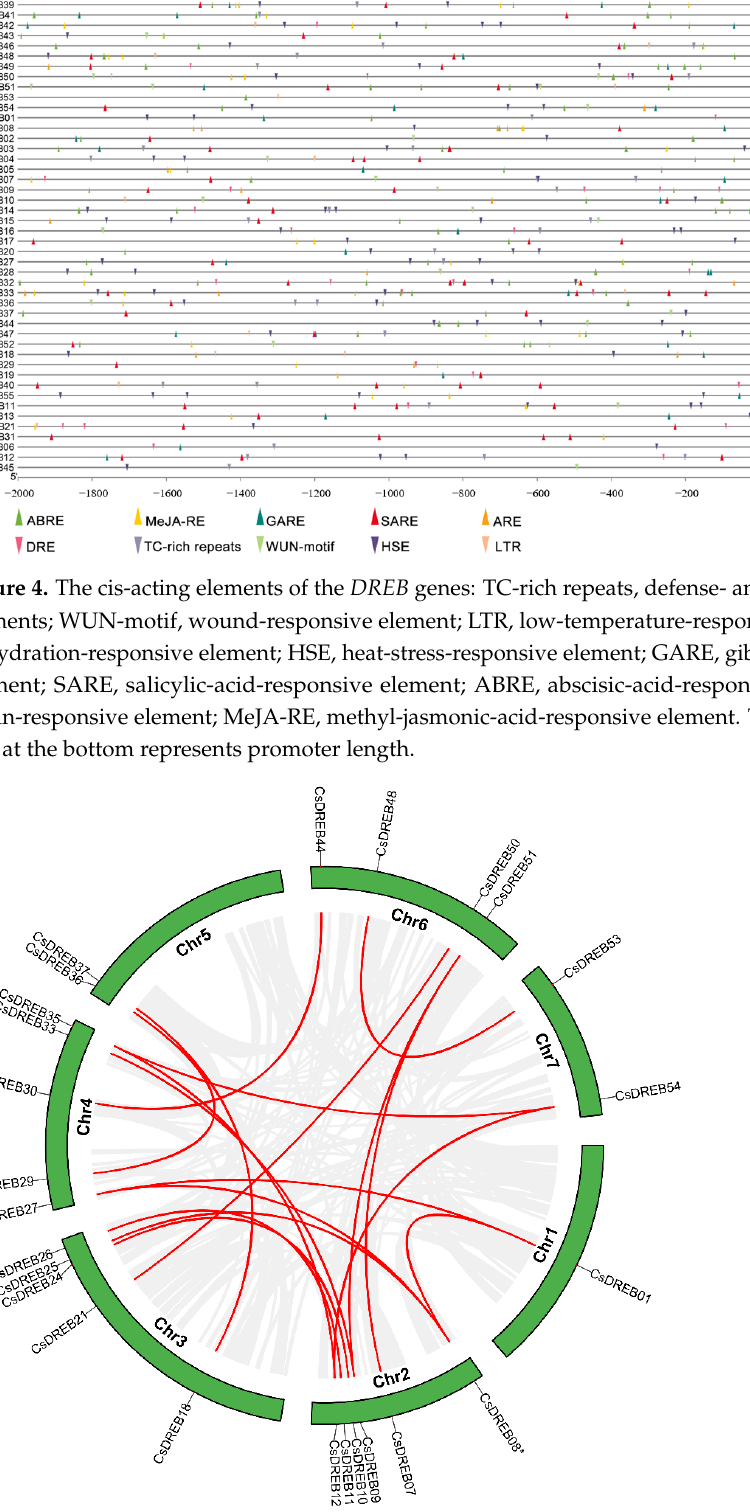
Figure 5. Schematic representations for the inter-chromosomal relationships of CsDREBs : Gray lines show synteny blocks in the cucumber genome. Duplicated CsDREB gene pairs are connected with red lines.